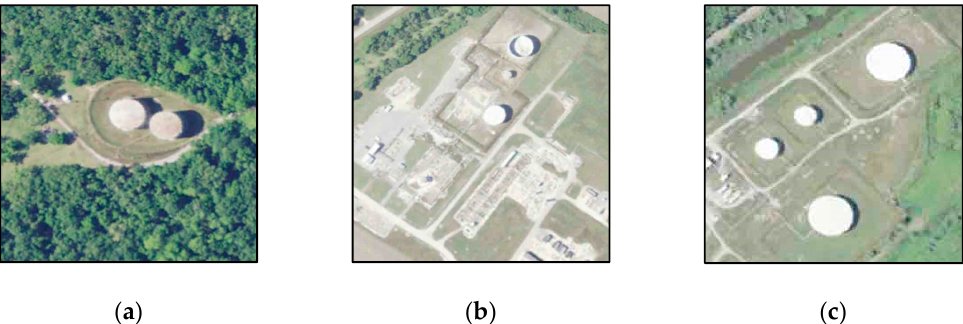
Figure 8. Google Map images during December 2010 around locations with high coherence; ( a ) GCP (EAST) [47], ( b ) GCP (WEST) [48], ( c ) GCP(VAL) [49]. Refer to Figure 1 for the locations of these points in the Wax Lake wetlands.